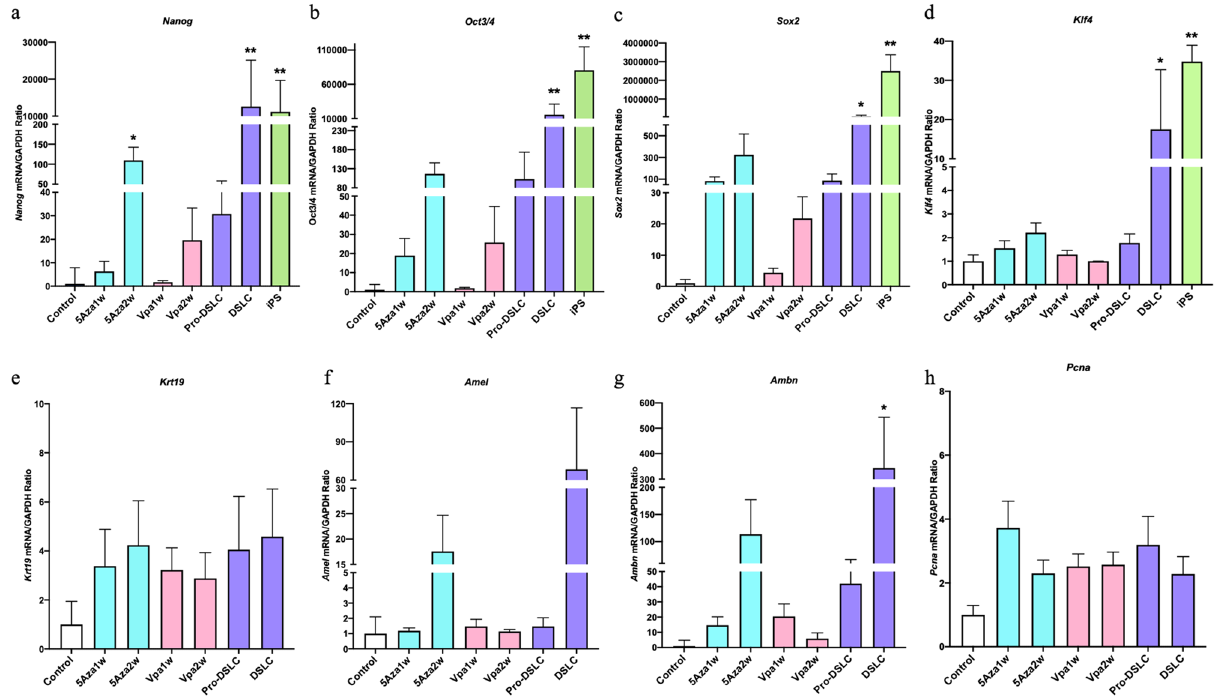
Figure 3. Bar graphs showing the results of the quantitative real-time reverse transcription polymerase chain reaction (qRT-PCR) in the control (ERM cells) and experimental cells. The expression levels of all the stem cell markers, including Nanog , Oct3/4 , Sox2 , and Klf4 were significantly higher in the DSLCs and iPS cells when compared to those in the controls (** p < 0.01, * p < 0.05; Kruskal–Wallis test, n = 5; a – d ). No significant increases in the expression levels of the odontogenic markers, except for Ambn , were observed in the DSLCs (e–g). In the cells treated with 5Aza alone for 1 week and followed by ESCM alone for another week (5Aza2w), the expression levels of Nanog were significantly upregulated (* p < 0.05; a – g ). No significant increase in the expression level of any of the markers was noted in the Pro-DSLCs, the cells treated with 5Aza alone for 1 week (5Aza1w),